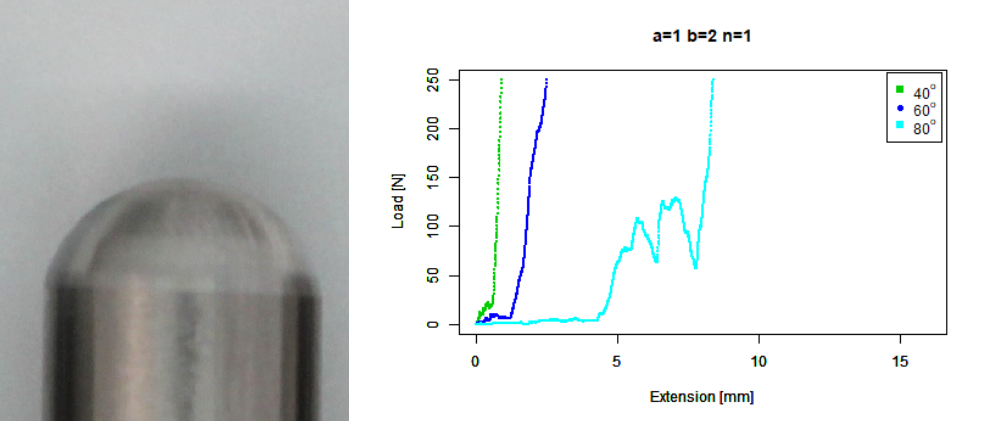
Figure 13. Basic round tip. ( Left ) Tip Profile. ( Right ) Experimental